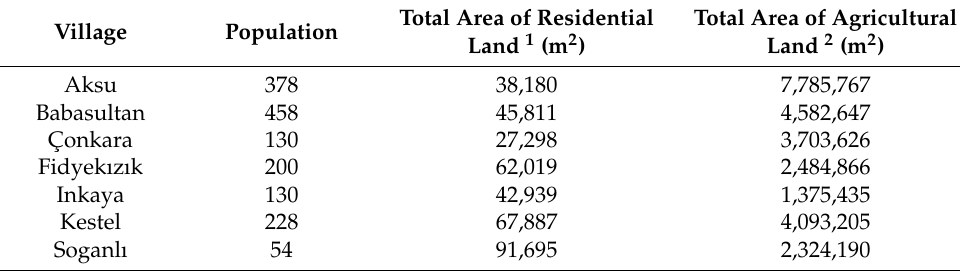
Table A1. Information on population and area of residential land across seven settlements of Bursa. Village Population